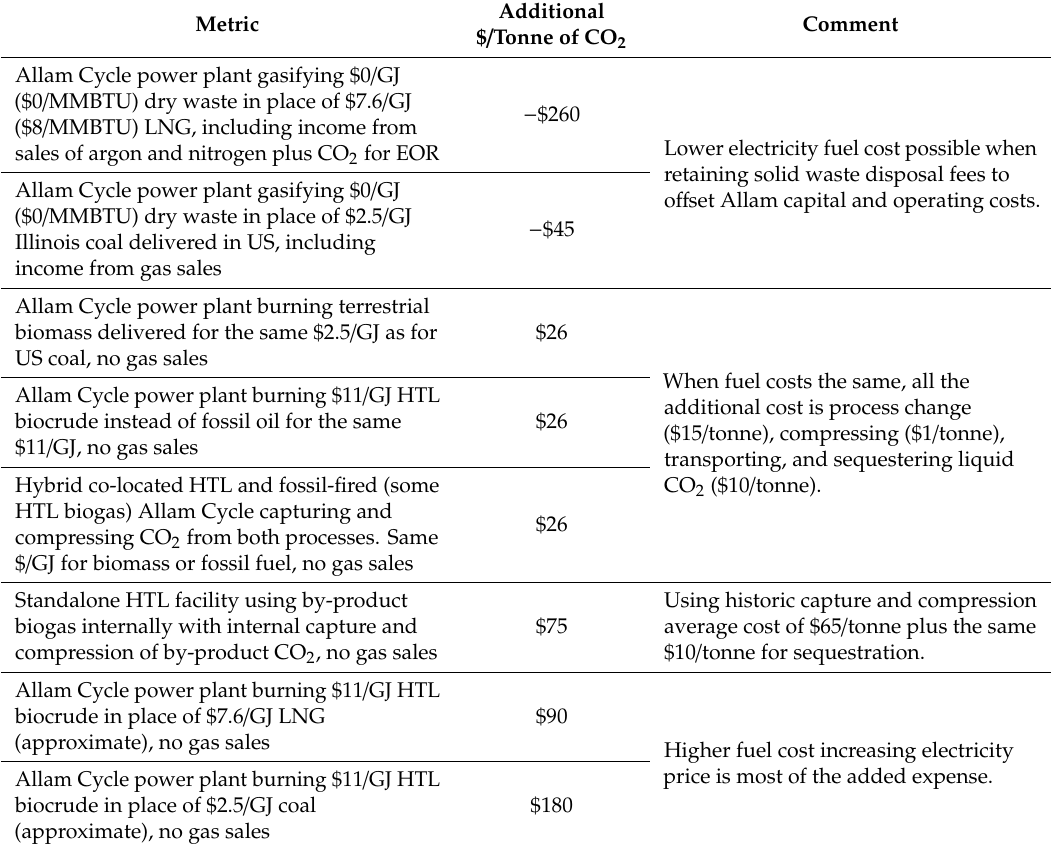
Table 5. Added cost to society for capturing, compressing, and sequestering CO 2 , changing from various fossil fuels to biomass fuels, and changing to Allam Cycle. Each row reflects a di ff erent local situation. Negative numbers mean reduced costs but are limited to early adopters using dry waste for fuel and able to sell gases. “No gas sales” means demand for more CO 2 , argon, or nitrogen has dropped to zero. Results are calculated in SMS#14, 16. Additional Metric Comment $ / Tonne of CO 2 − $260 Lower electricity fuel cost possible when retaining solid waste disposal fees